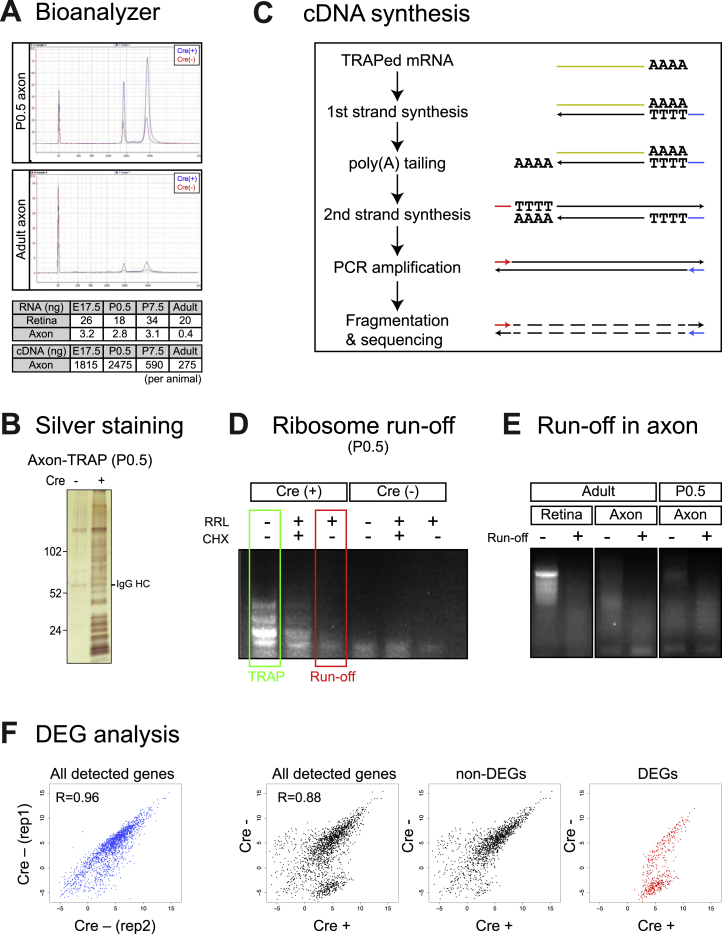
Axon-TRAP, Related to Figure 2(A) Bioanalyzer analysis of axon-TRAPed mRNA. Lower tables show the amounts of total RNAs and amplified cDNAs for each TRAPed sample.(B) Silver staining of axon-TRAPed protein complexes following SDS-PAGE.(C) Strategy for cDNA synthesis and amplification adapted from the study by Tang et al.(D) Ribosome run-off experiment. The amplified cDNAs from TRAPed mRNAs with or without run-off (P0.5 retina).(E) Retinal and axon-TRAP combined with ribosome run-off.(F) Scatterplots of log2 (FPKM) between Cre-positive (x axis) and Cre-negative axons (y axis).